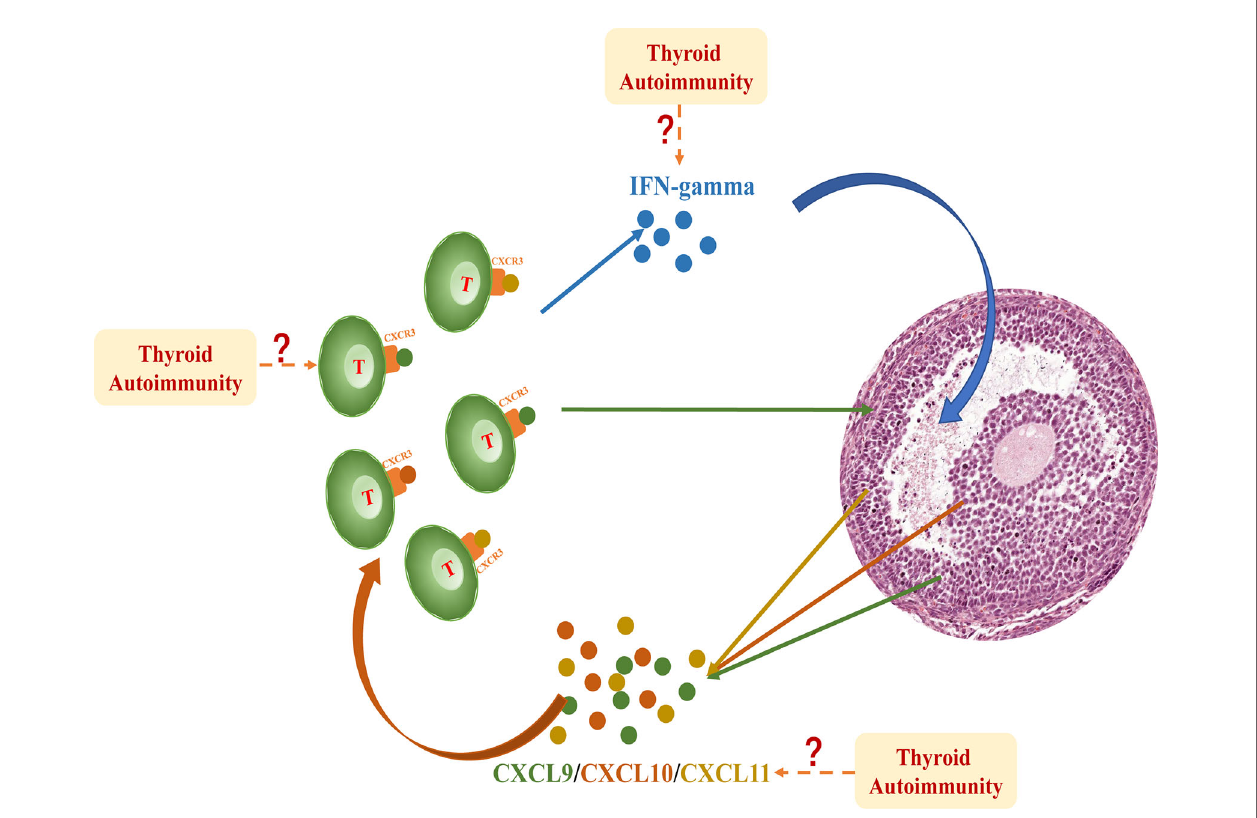
FIGURE 4 | IFN g produced by T lymphocytes dose-dependently induced the expression and secretion of CXCL9/10/11 in primary granulosa cells. These chemokines bind to their receptor CXCR3 and further promote the migration of T lymphocytes into the follicle, thereby perpetuating an in fl ammatory cascade in the follicular microenvironment. This intrafollicular response is signi fi cantly activated in patients with AIT; however, the initiation of this cascade is still unclear. The excess in fl ux of in fl ammatory cells and factors into the follicle fl uid may be involved in this